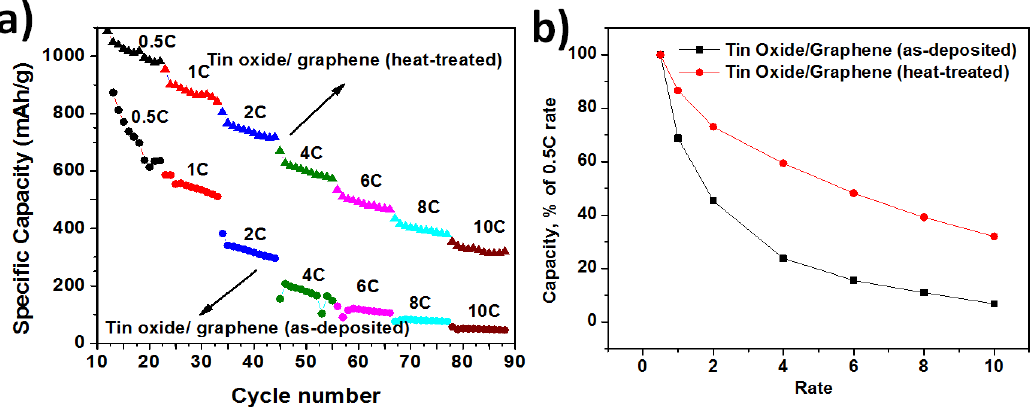
Figure 5. ( a ) Rate capability of TG composites—as-deposited and heat-treated; and ( b ) Normalized capacity vs. the rate of discharge of TG composites—as-deposited and heat